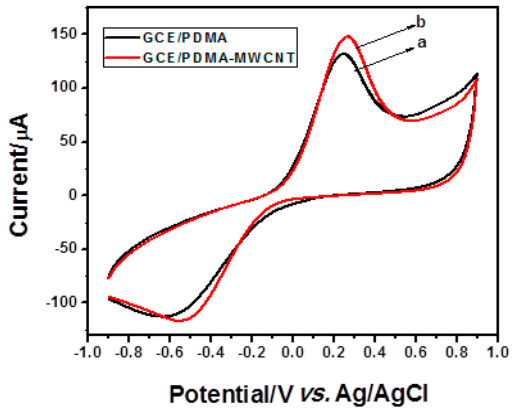
Figure 7. Cyclic voltammograms of ( a ) PDMA and ( b ) PDMA-MWCNT electrodes in 0.1 M phosphate buffer (PBS) at 100 mV·s − 1 .